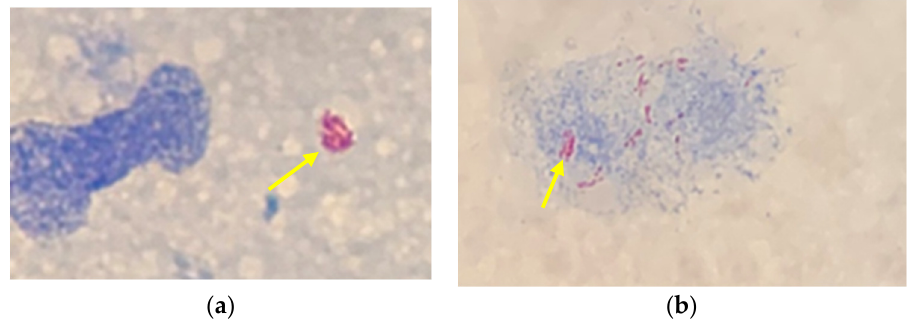
Figure 2. Acid-fast stain of slit skin smears of ( a ) left earlobe and ( b ) left elbow showing AFB-posi- tive bacteria (yellow arrows). bacteria (yellow